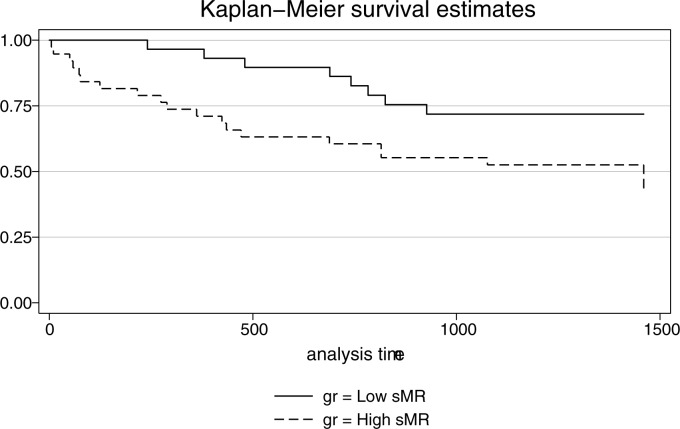
sMR and survival.Kaplan-Meier 4-year survival estimates in alcoholic cirrhosis patients according to the plasma level of sMR. The cut-off used was 0.43 (mg/L) (P = 0.03, Log-rank).